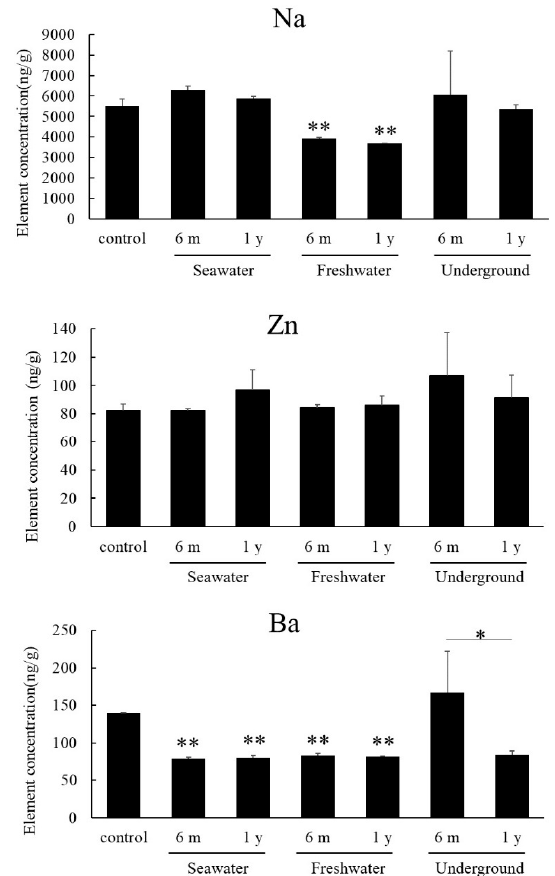
Figure 6. Quantitative analysis of Na, Zn, and Ba in the control and three environmental conditions by inductively coupled plasma optical emission spectroscopy (ICP-OES). Means and standard deviations are presented. * p < 0.05, ** p < 0.01 vs. control. Table 2. Qualitative and semiquantitative analyses of 30 elements by ICP-OES.